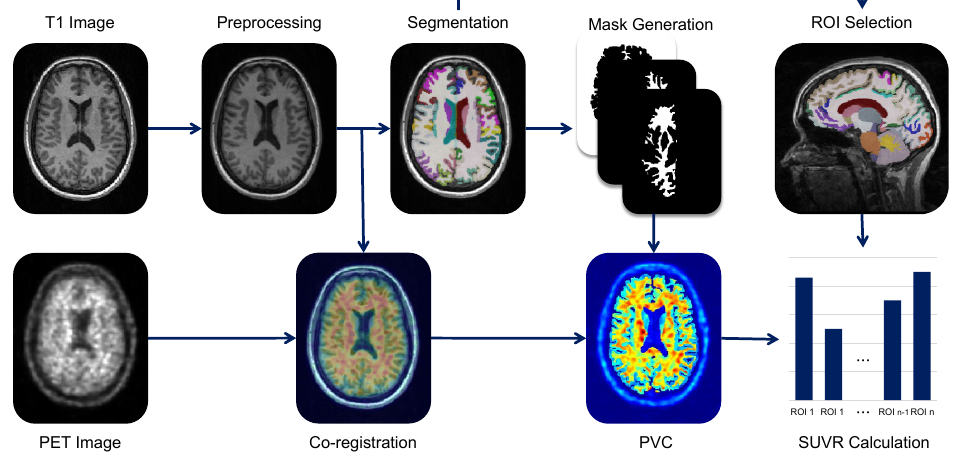
Figure 1. Overview of our proposed PET image processing pipeline. Our proposed pipeline comprises four steps. Step 1 is MRI processing with preprocessing and deep learning-based segmentation. Step 2 is co-registration with preprocessed MRI and PET. Step 3 is partial volume correction (PVC) of PET image. Finally, Step 4 is SUVR quantification from